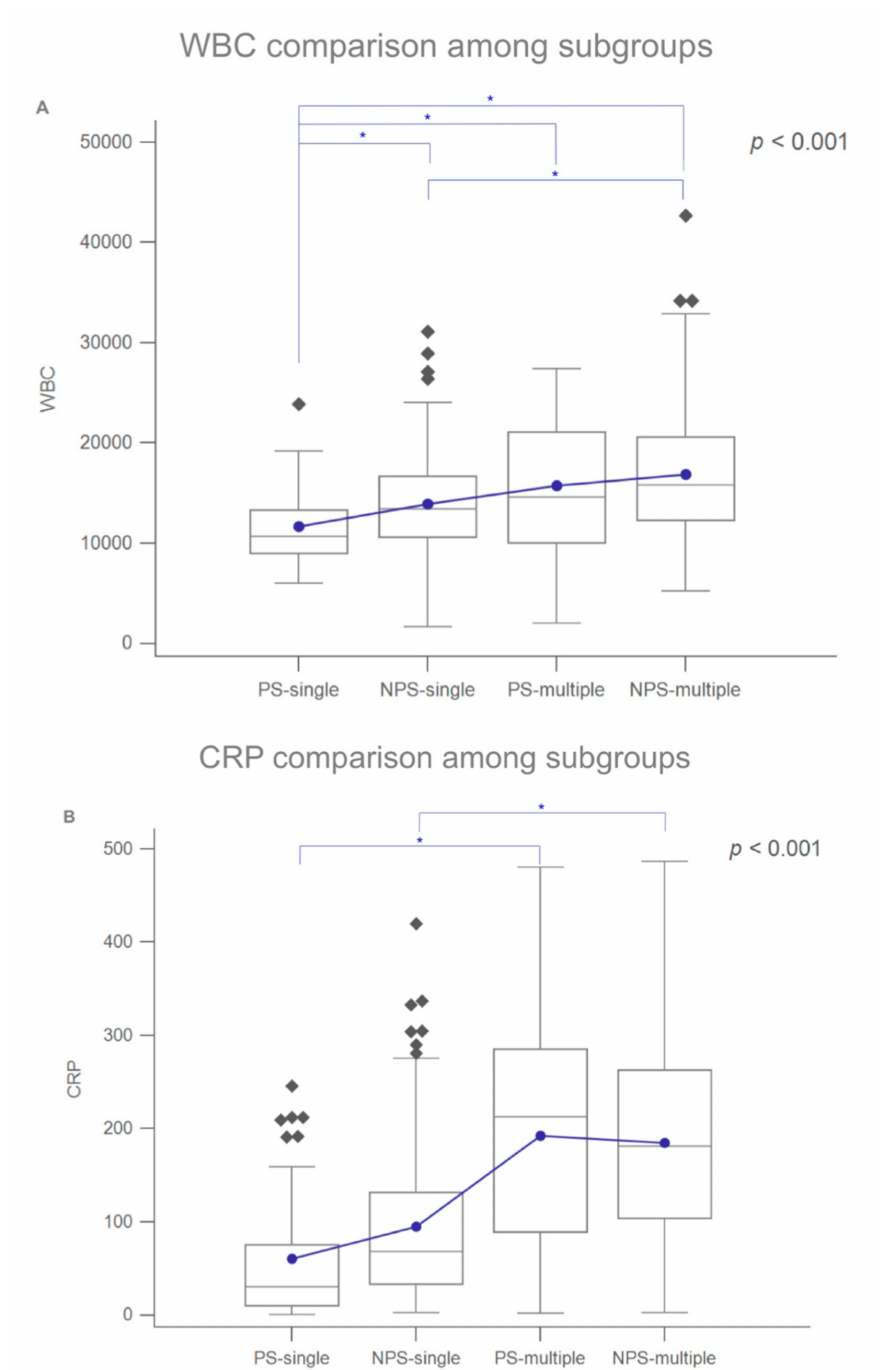
Figure 1. ( A ) Box-and-whisker plots of the laboratory data for the four subgroups. WBC counts of the subgroups. ( B ) CRP levels of the subgroups. Blue dots: means; diamonds: mild outliers; squares: extreme outliers. Blue lines/asterisks indicate statistical significance ( p <